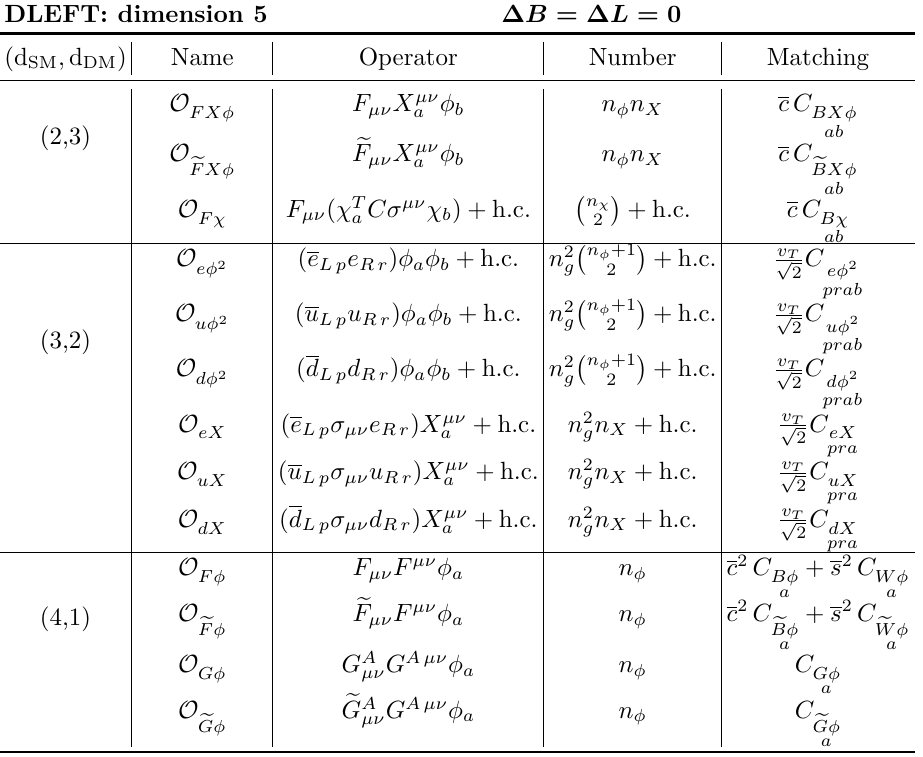
Table 19 . Dimension-five ∆ B = ∆ L = 0 operators in DLEFT. Note that O the same as Q and Q , etc. The first column gives the dimensions of the SM and DM part of eX eφ 2 the operator, the fourth column is the number of operators, and the fifth column is the additional matching contribution at the EW scale.